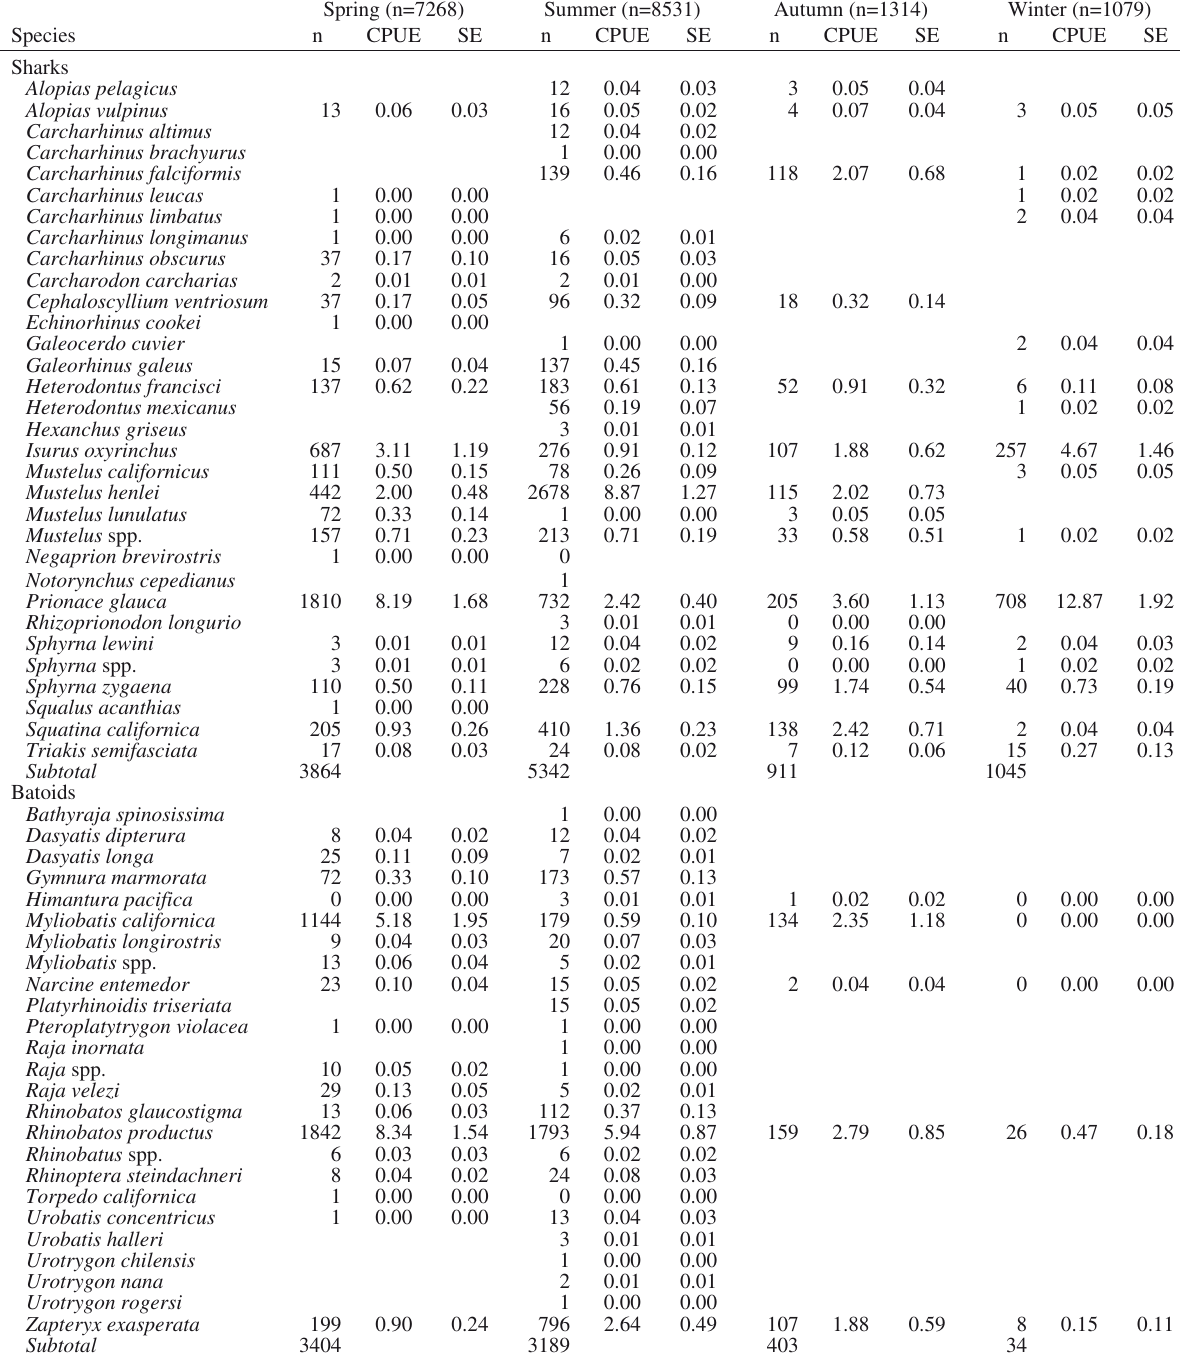
Table 5. – Seasonal catch per unit effort (CPUE) and standard error (SE) for elasmobranch species sampled on the Pacific coast of Baja California Sur during the period 2000-2010. Spring (n=7268)